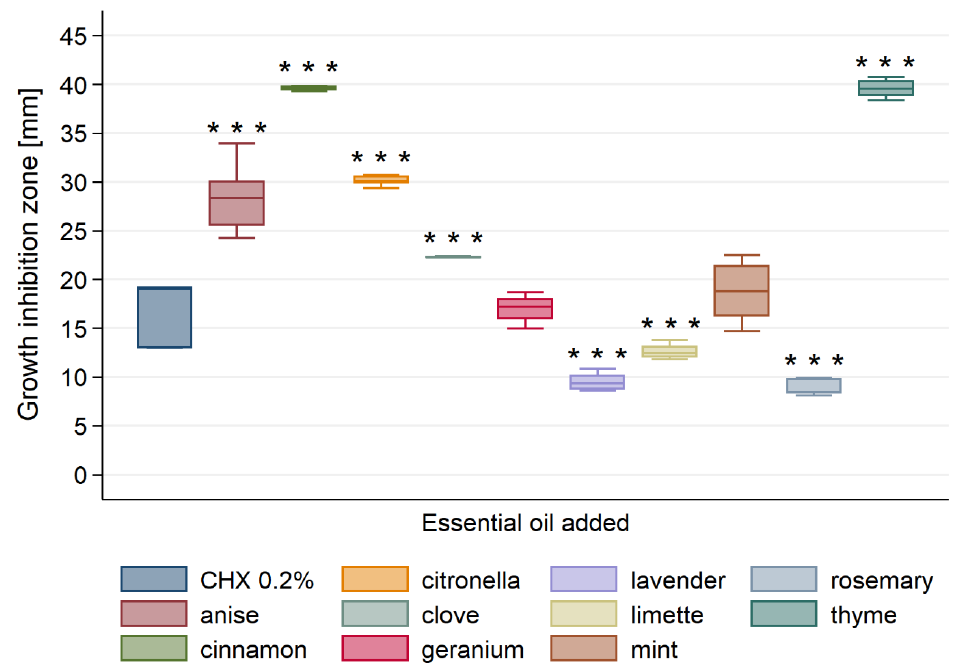
Figure 3. Antibacterial activity of tested essential oils against L. acidophilus . *** p < 0.001 versus positive control (0.2%